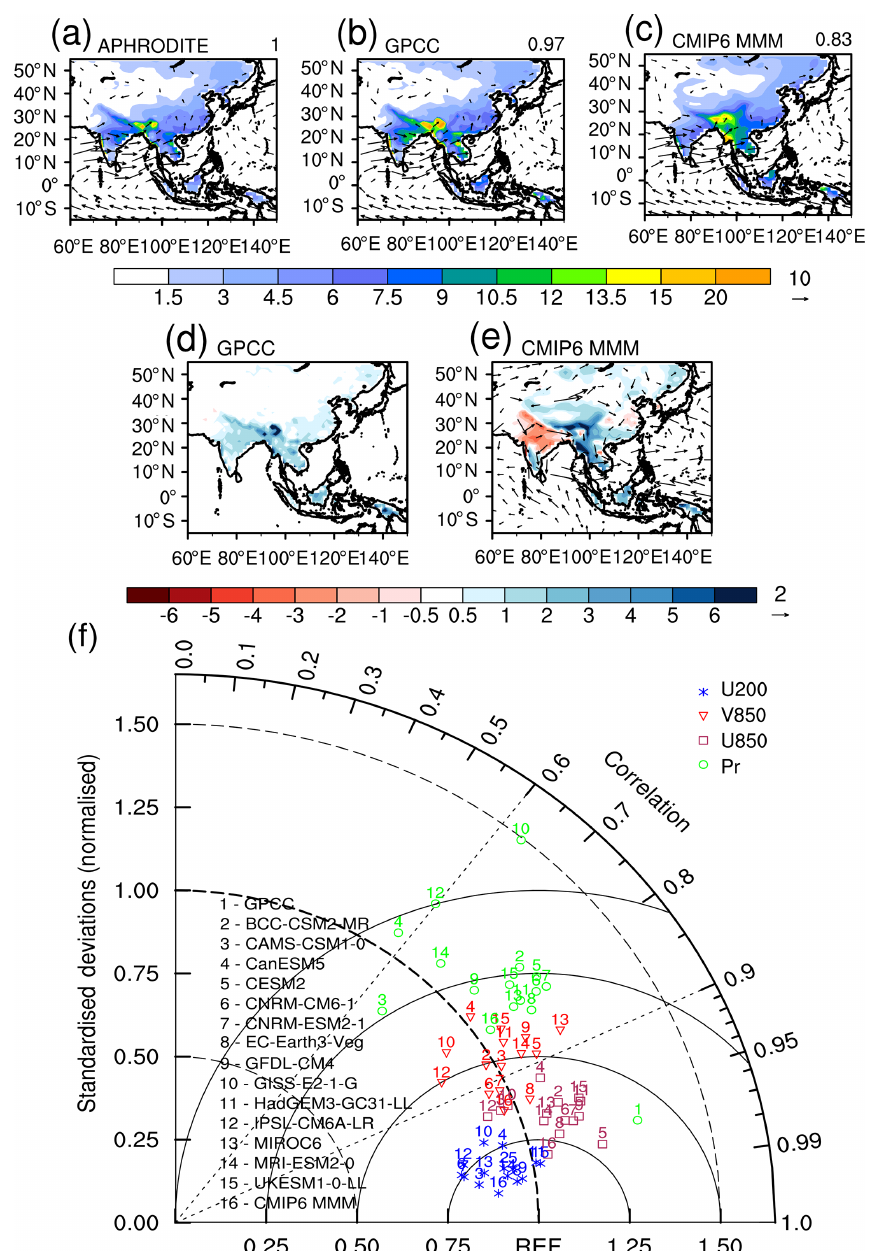
Figure 5. JJA-mean 1980–2014 mean precipitation over land (mmd − 1 ) overlaid with 850hPa wind (ms − 1 ) from (a) APHRODITE and ERA-Interim, (b) GPCC and ERA-Interim, and (c) CMIP6 (multi-model mean). Values in the top right corner of (a–c) show the pattern correlation with APHRODITE precipitation. (d) Precipitation bias in GPCC relative to APHRODITE. (e) CMIP6 precipitation relative to APHRODITE and CMIP6 850hPa winds relative to ERA-Interim. (f) Taylor diagram showing the relationship between individual CMIP6 models, the CMIP6 multi-model mean (point 16), GPCC (point 1), and APHRODITE precipitation and ERA-Interim